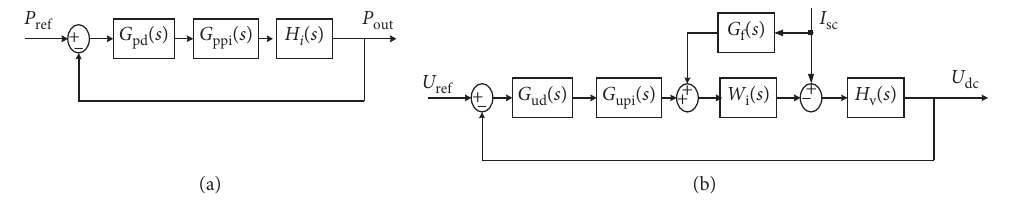
Figure 5: Double closed-loop control technology. (a) Power inner loop. (b) Voltage outer